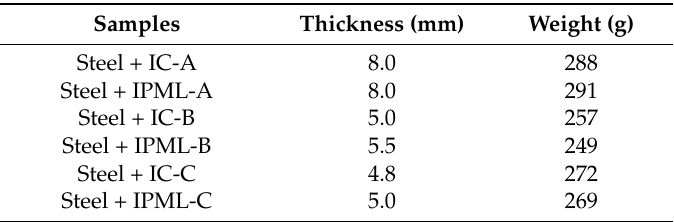
Table 2. IC and IPML